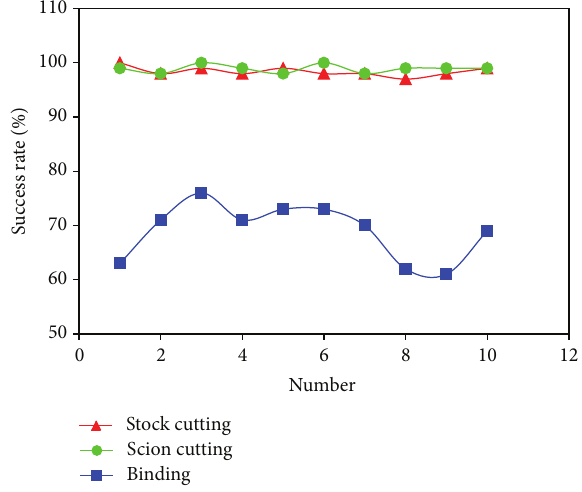
Figure 15: Curves of stock cutting, scion cutting, and binding success